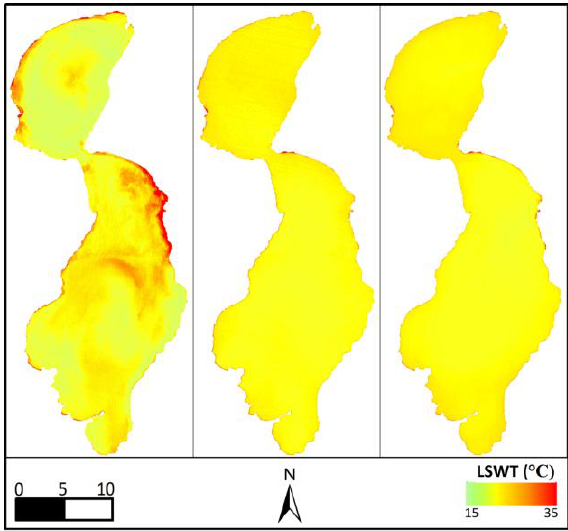
Figure 6 . The Egirdir Lake LSWT maps for the years 1998, 2008 and 2018, respectively, from left to right.